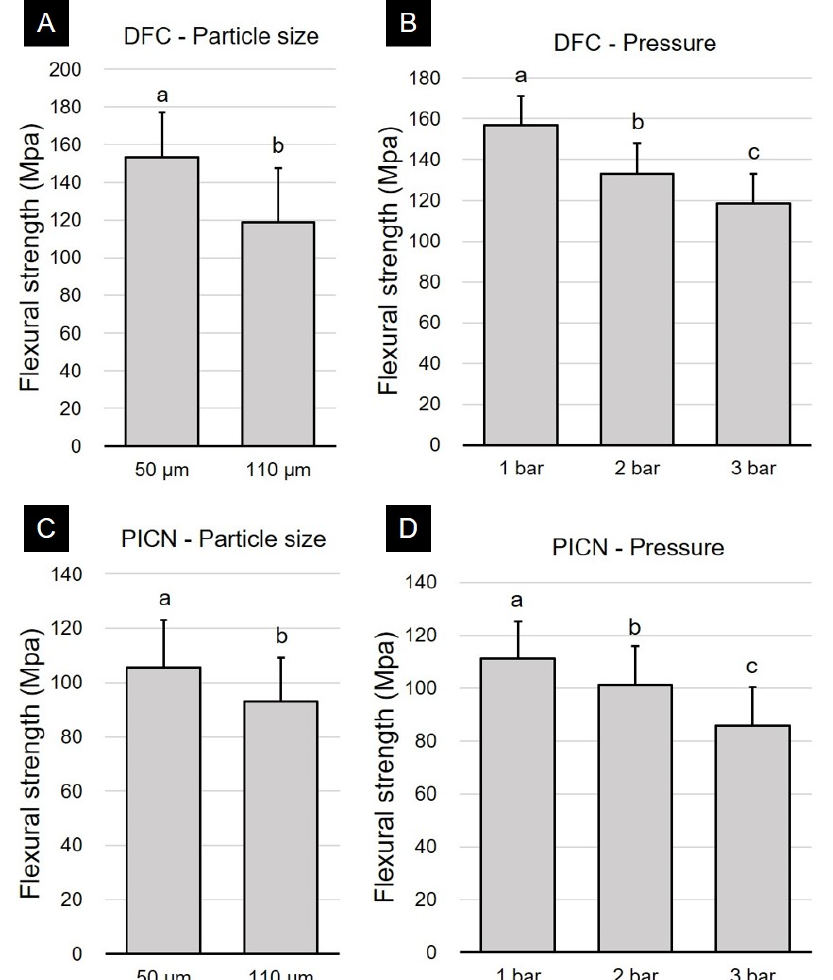
Figure 1. Two-way ANOVA results of surface treatment on the flexural strength of disperse-filled composites (DFC) and polymer-infiltrated ceramic networks (PICN) specimens with respect to ( A , C ) Al 2 O 3 particle size and ( B , D ) air abrasion pressure (mean + standard deviation). Different lowercase superscript letters indicate significant differences in flexural strength.